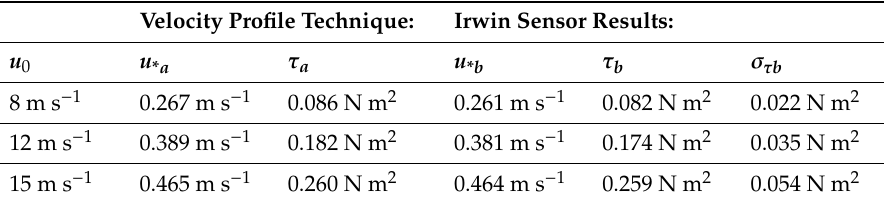
Table 1. The fitting results of wind tunnel